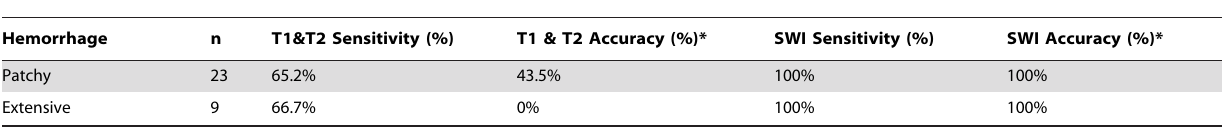
Table 3. Sensitivity and Accuracy by Pattern of